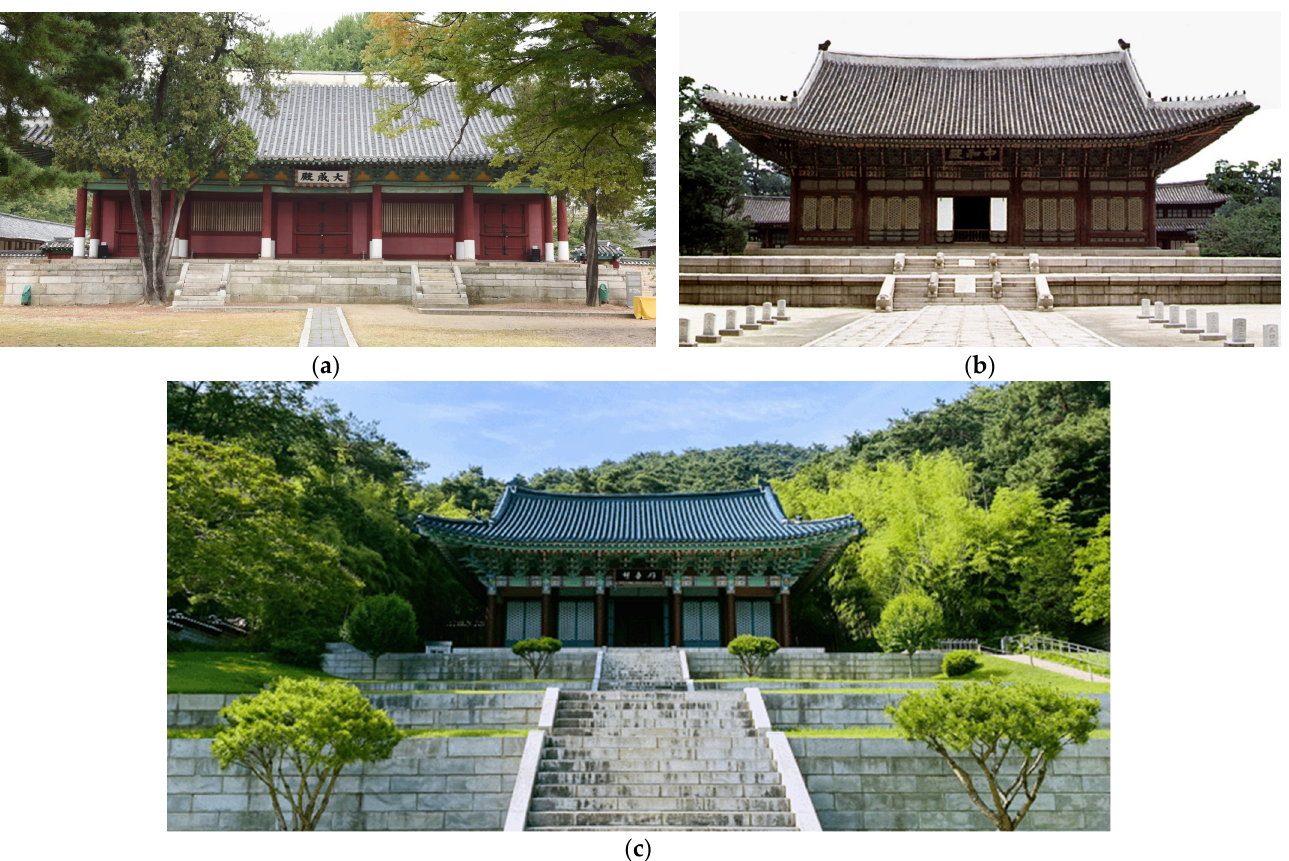
Figure 14. Comparison of Façade Design ( a ) Daeseongjeon Hall of Munmyo Shrine ( b ) Main Hall of Deoksugung Palace ( c ) Main Hall of Hyeonchungsa (Source: Cultural Heritage Administration).